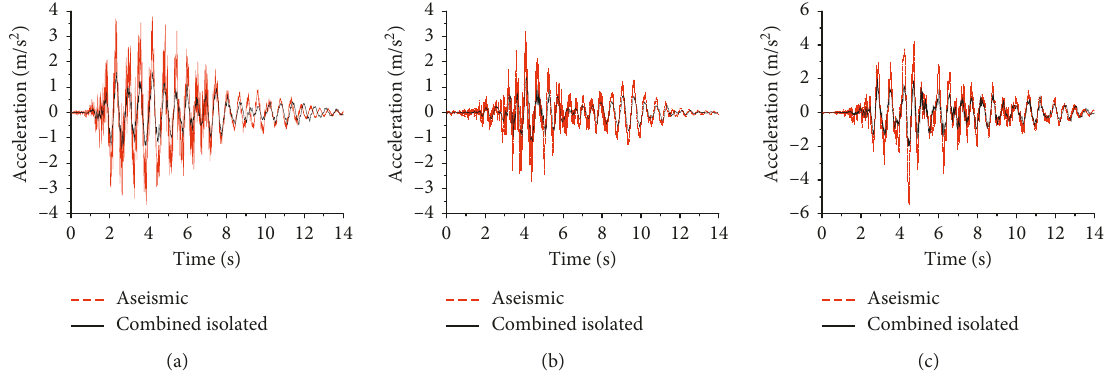
Figure 4: Y -axis acceleration time histories curve of the top floor of the third subframe. (a) Chi-Chi-2N, (b) Chi-Chi-2F, and (c)